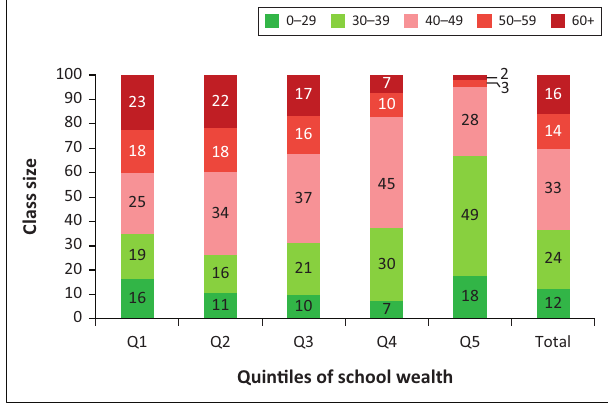
FIGURE 5: Distribution of largest class taught by Grade 3 and 6 teachers in South African primary schools by school wealth